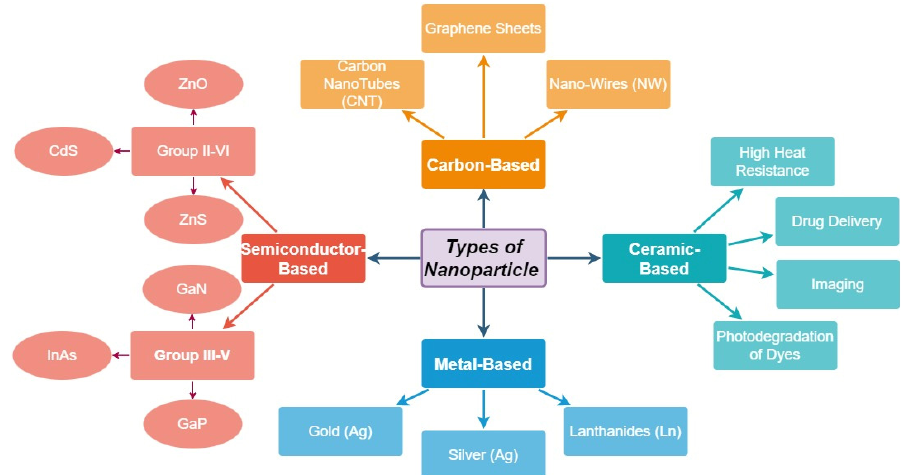
Figure 1. Classification of nanoparticles, in compliance with size, shape, and physical and chemical characteristics.